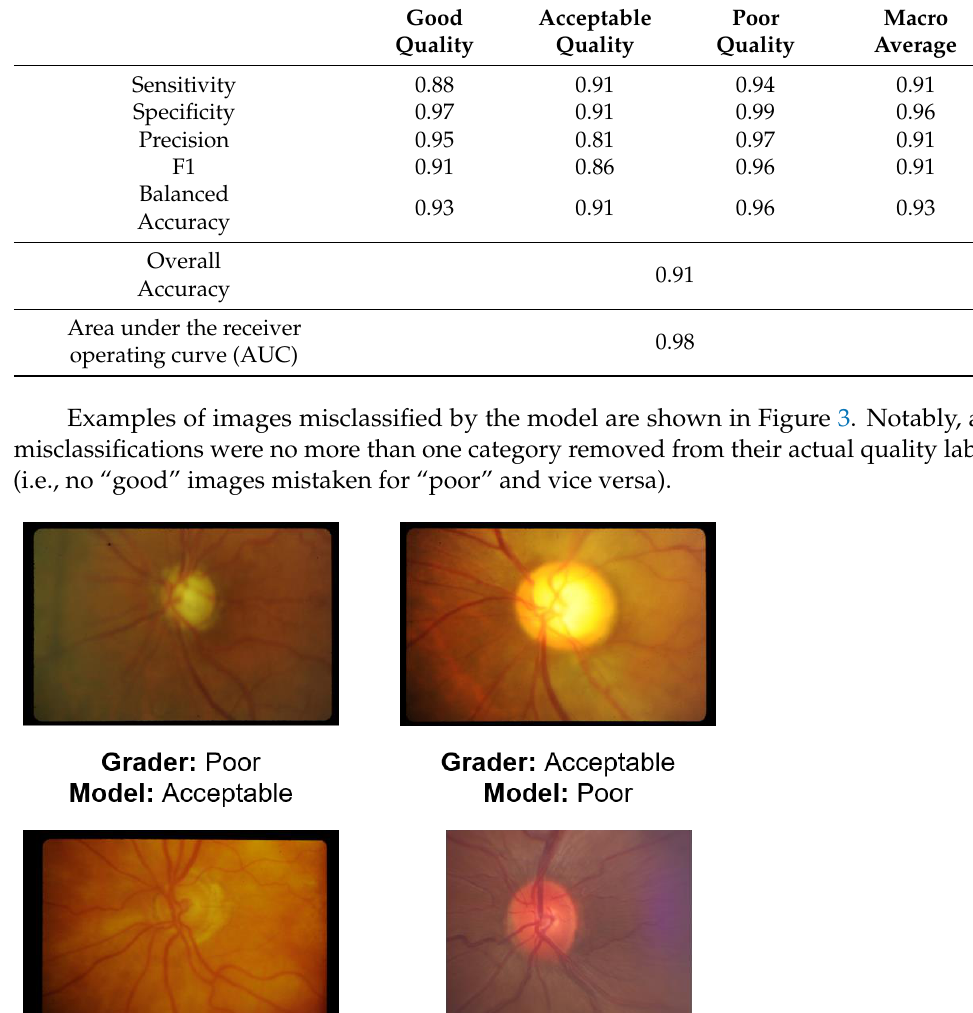
Table 3. Performance metrics for the binary outcome model. Sensitivity